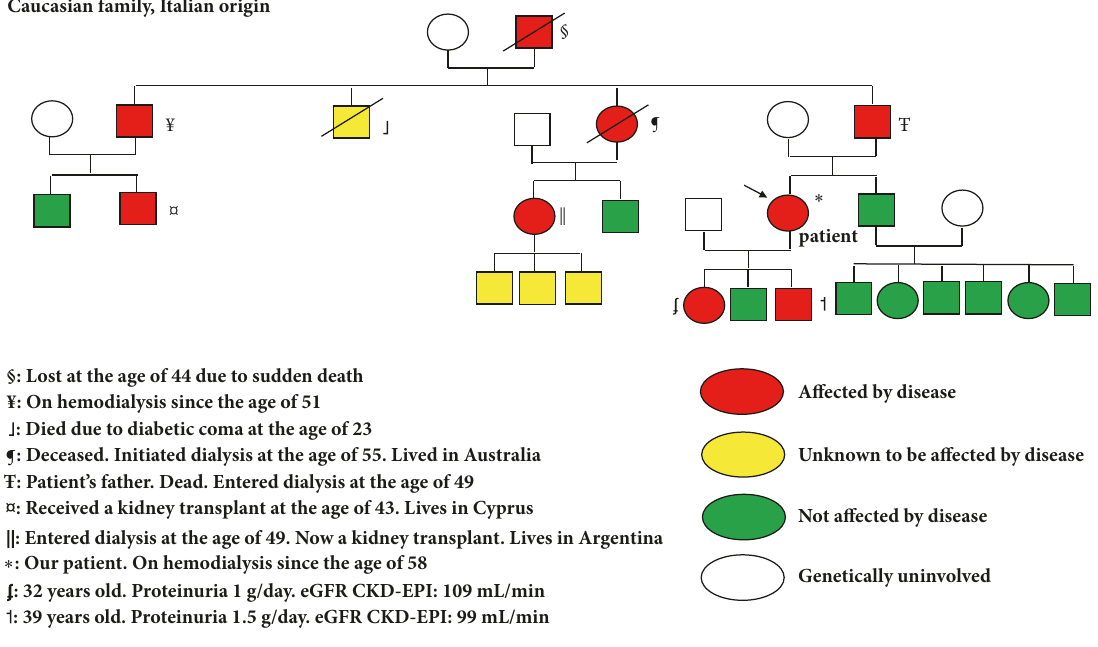
Figure 1: Family